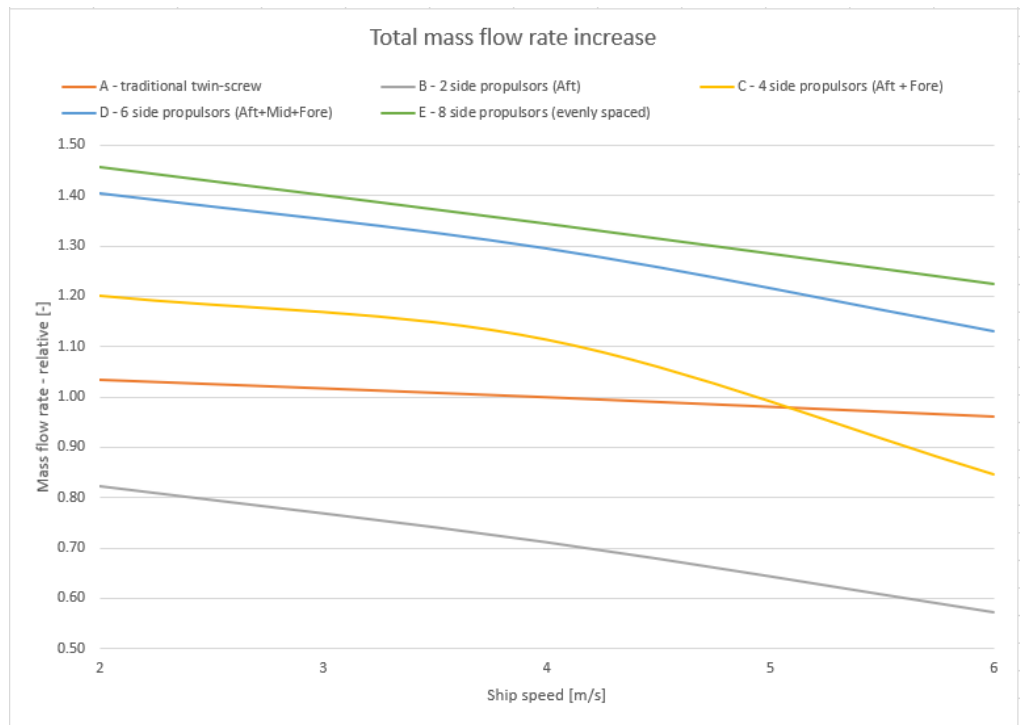
Figure 6. Total mass flow rate, deep water (comparison). Source: Authors.